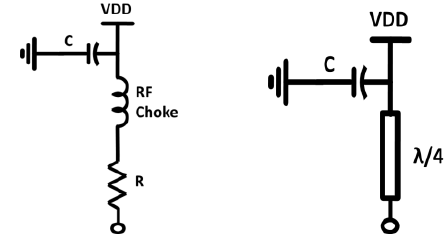
Figure 4: Schematic of gate DC bias line (left side) and drain DC bias line (right